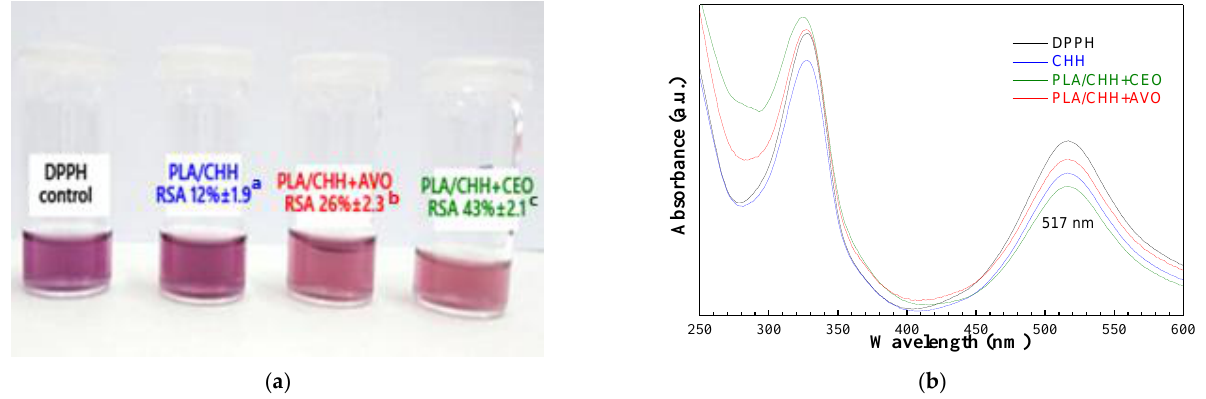
Figure 6. Photographs of DPPH solutions after 30 min dark incubation with/without polymeric samples ( a ) and UV-Vis spectra of DPPH scavenging by PLA-based samples unmodified and modified with oil-loaded coatings ( b ). a – c Mean values with different letters indicate significant differences at p < 0.05.